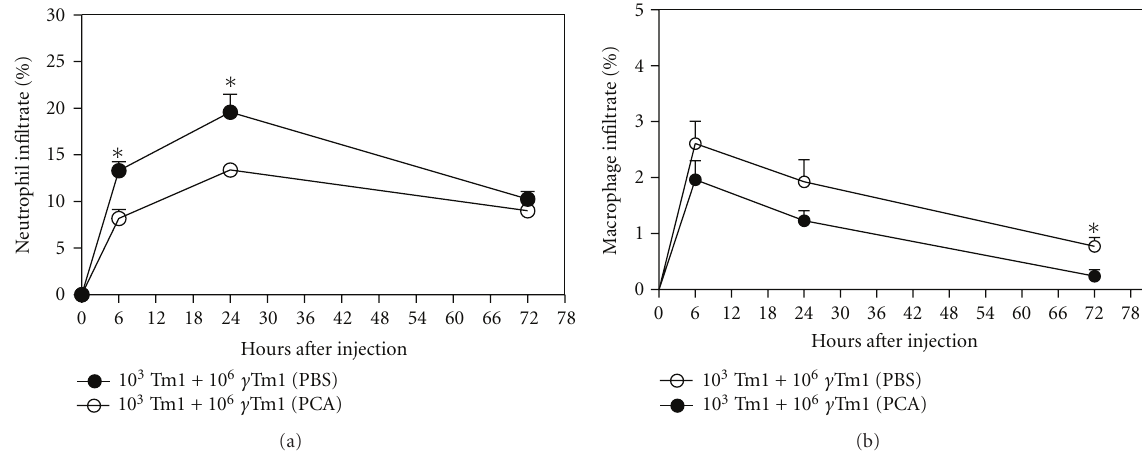
Figure 3: Treatment with PAFR antagonist reduces neutrophil and macrophage infiltration. The inhibition of PAFR using PCA4248 (PCA) results in reduced neutrophil and macrophage infiltration in mice submitted to coinjection of apoptotic cells (10 6 γ -irradiated Tm1) and a subtumorigenic dose of Tm1 melanoma cells (10 3 viable cells). Subcutaneous tissues from animals treated with PBS or PCA4248 (PCA), for 5 consecutive days, were surgically removed 6, 24 and 72 h after coinjection and processed for immunohistochemistry analysis using specific antibodies against myeloperoxidase (antigen expressed mainly by neutrophils, (a)) and F4/80 (cell marker by macrophages, (b)). ∗ Denotes statistical significance ( P < 0 . 05) using nonpaired nonparametric Student’s t